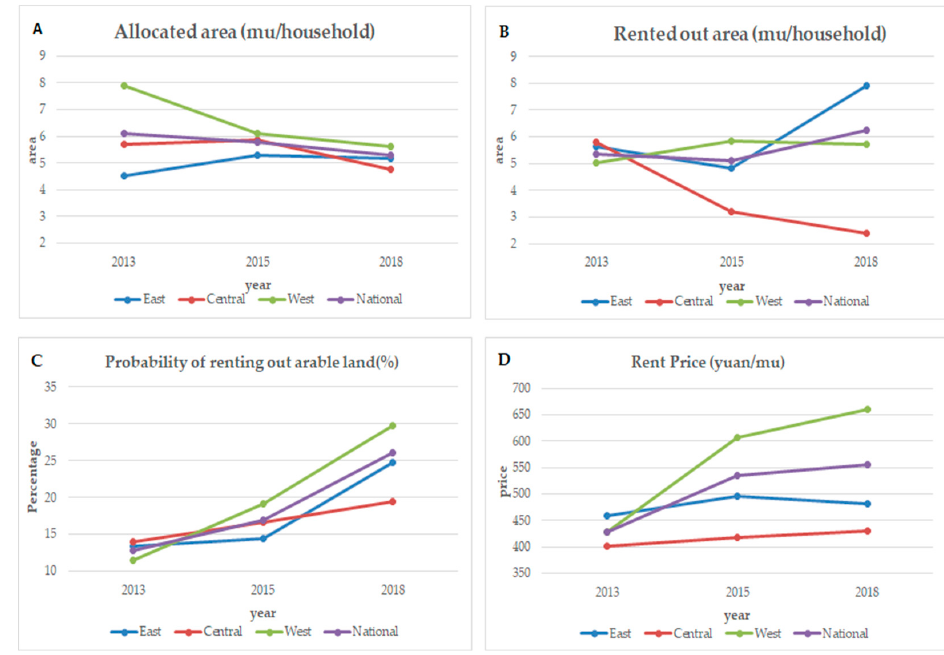
Figure 3. Renting out of arable land by elderly farmers in China at national level and in the eastern, central, and western regions. central, and western